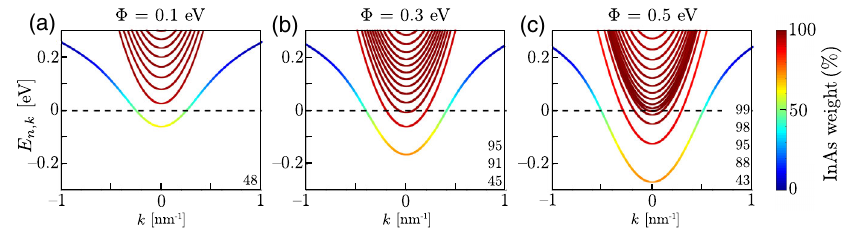
− 0 . 5 V. Increasing the D ¼